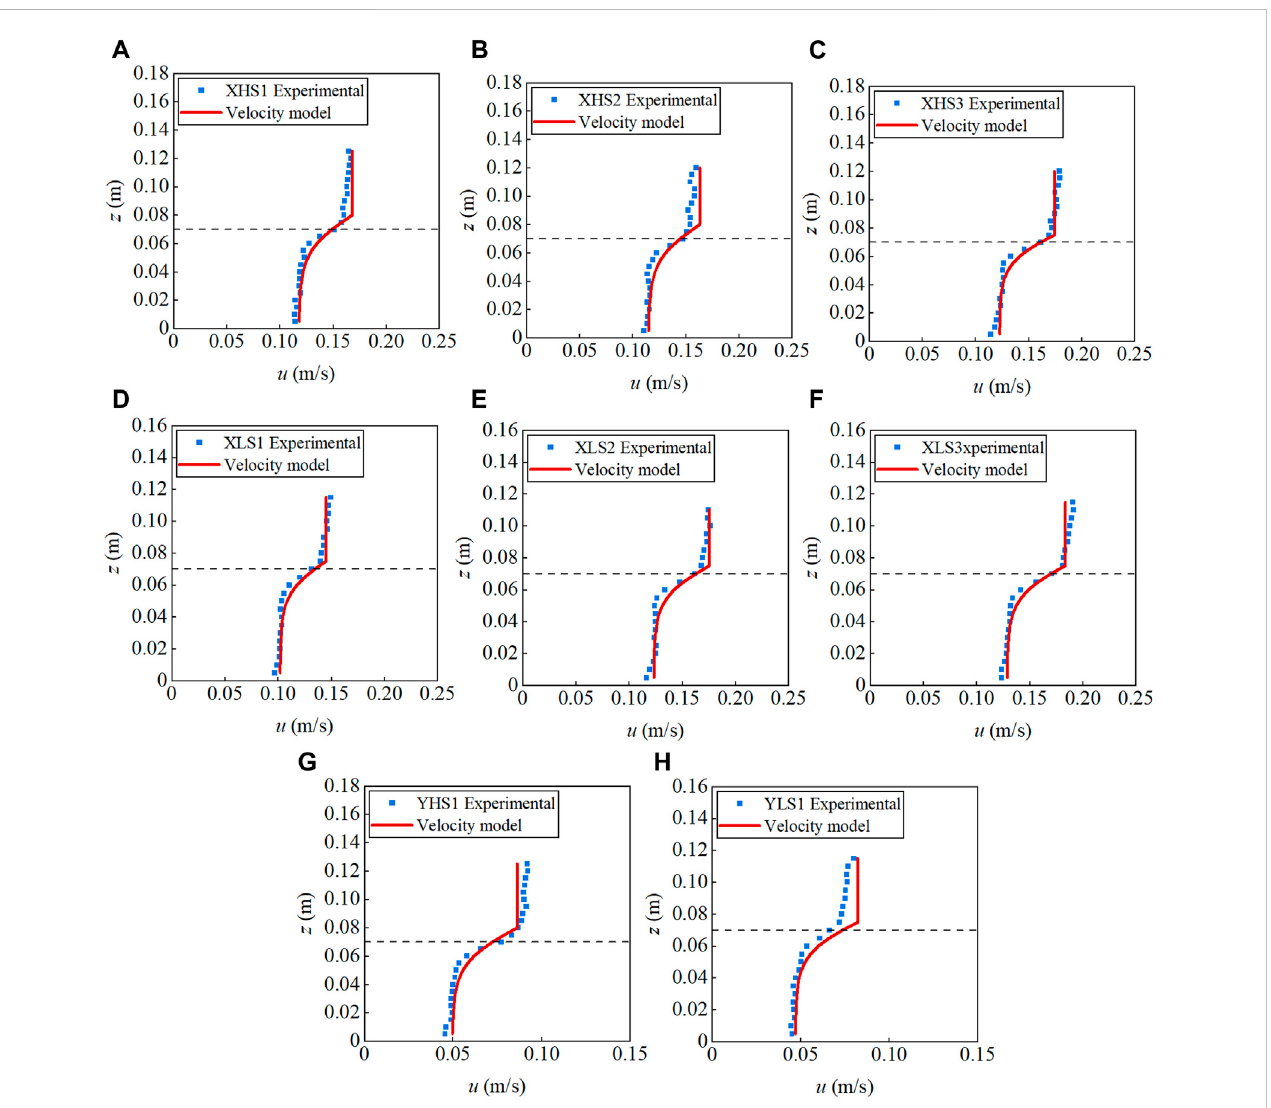
FIGURE 7 Thevelocitypro fi le oftheexperimentaldataandpredictedmodelforrunsXandrunsY,theblackdottedline representstheheightoftheshortcylinders. (A-F) present results for runs X, and (G, H) present results for runs